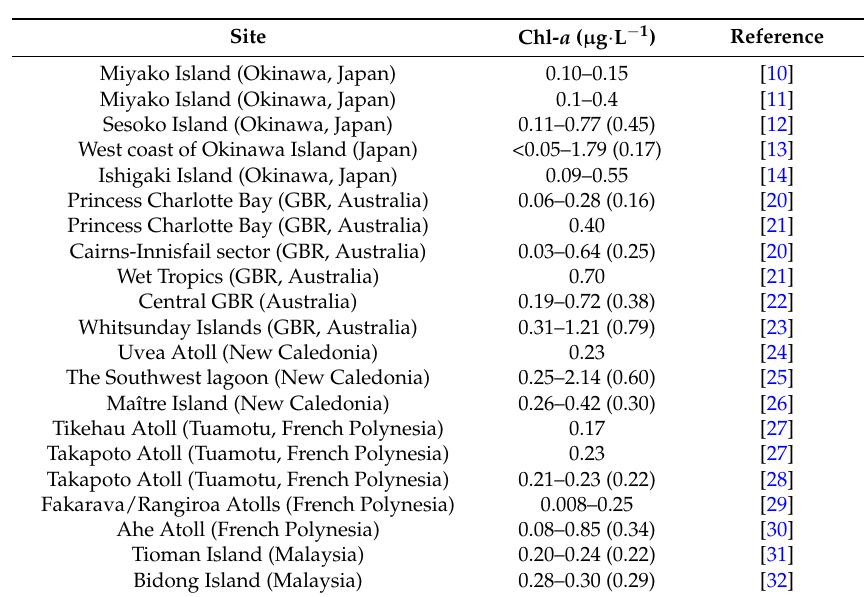
Table 1. Chlorophyll- a (Chl- a ) concentrations in various coral reef waters. Some values were visually interpreted from figures. The values in parenthesis are the mean of several data in the study. GBR, Great Barrier